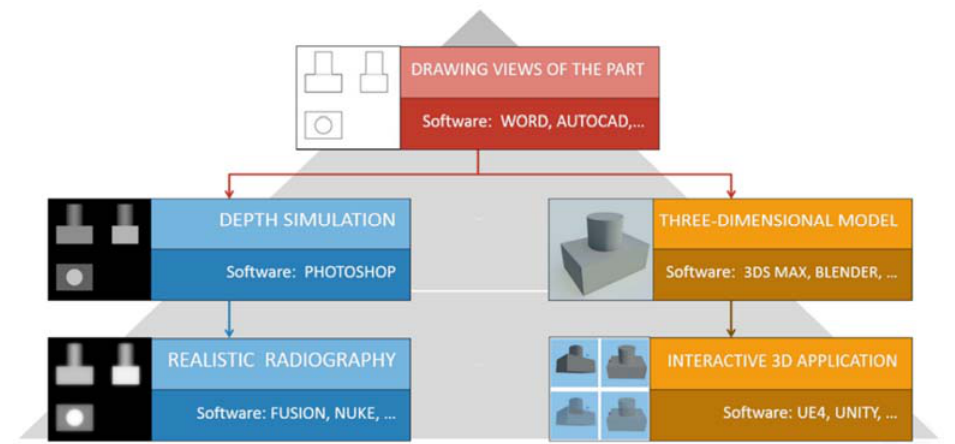
Figure 6. Methodology used for the creation of the didactic material.